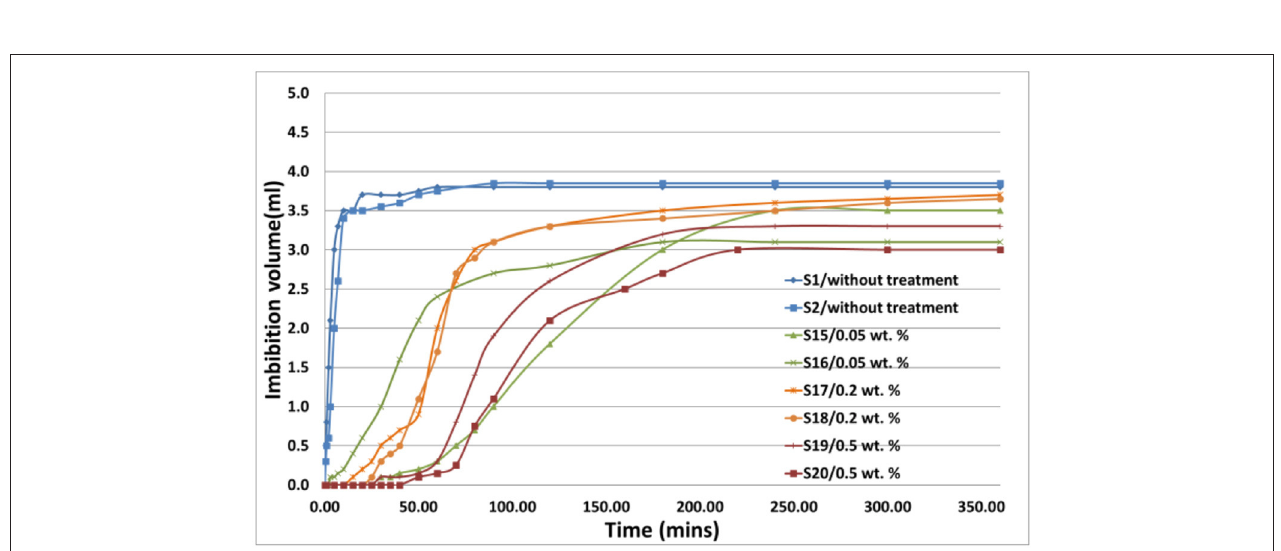
FIGURE 8 | Spontaneous imbibition curves for core plugs treated with FNP-O.